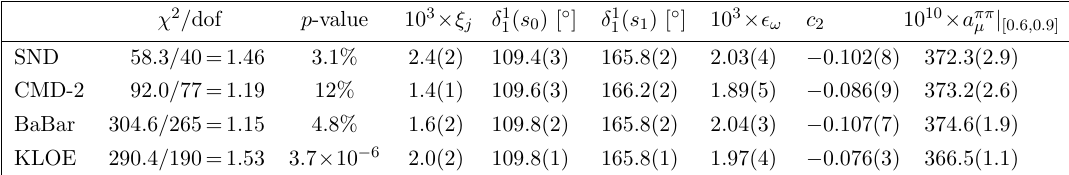
Table 4. The same as table 2, but with an energy rescaling for each experiment according to